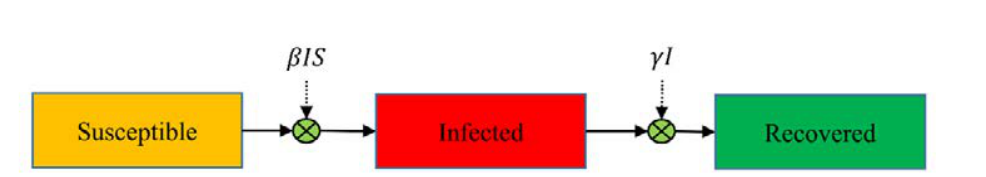
Fig. 1. The block diagram of the SIR model for epidemic and pandemic (i.e. COVID-19).